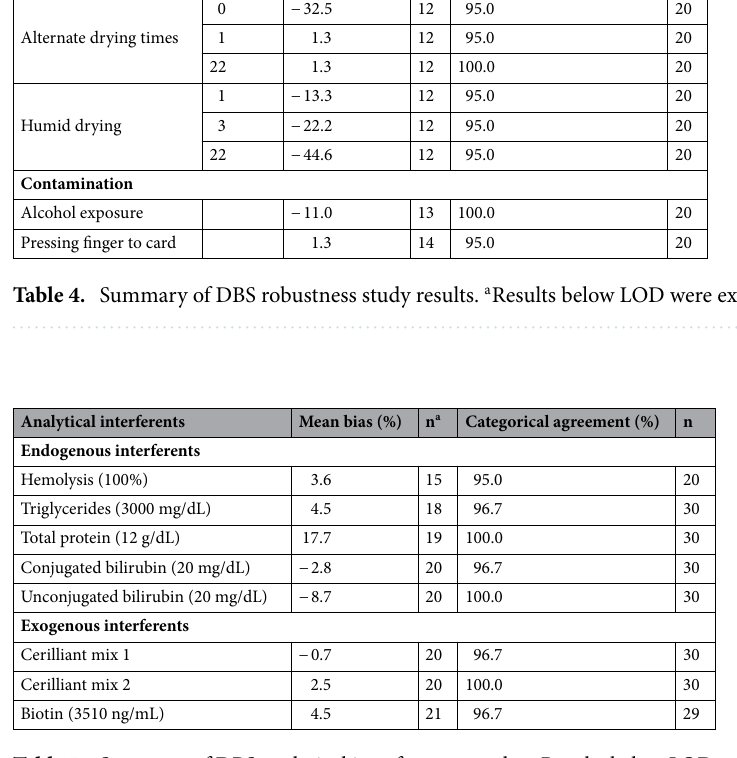
Table 5. Summary of DBS analytical interference results. a Results below LOD were excluded from bias